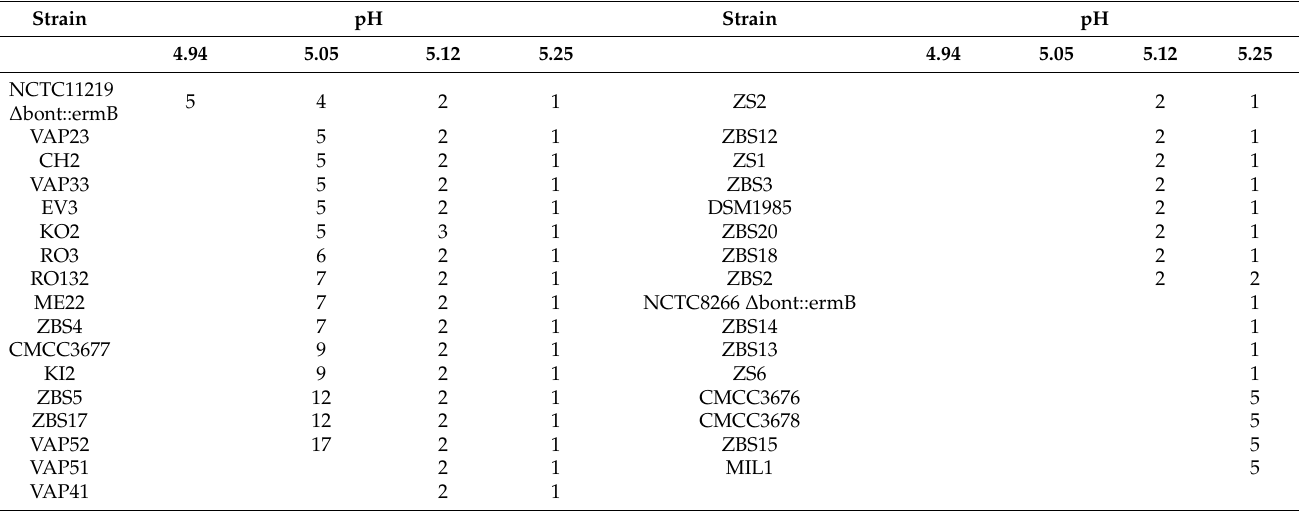
Table 6. Growth of nontoxic isolates, NCTC8266 ∆ bont::ermB and NCTC11219 ∆ bont::ermB in RCM broth acidified with 1 M HCl to pH 4.94–5.25. Growth was monitored for 21 days for three replicates per